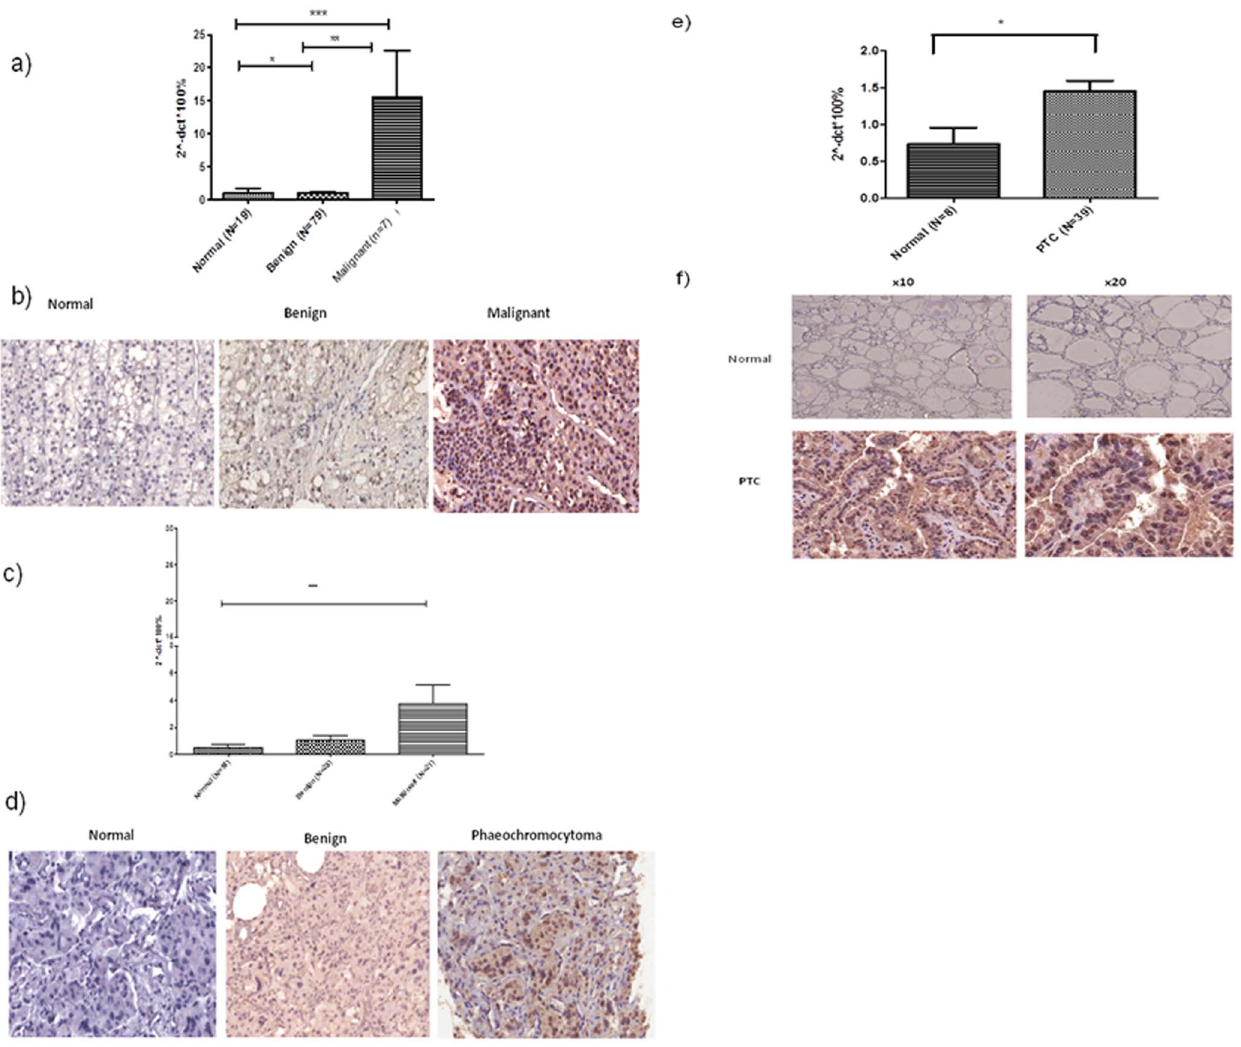
Figure 1. ZNF367 mRNA and protein levels in adrenocortical carcinoma, papillary thyroid cancer, and pheochromocytoma/ paraganglioma compared to benign and normal tissue samples for each cancer type. (A and B) Expression level in the normal adrenal cortex, benign adrenocortical adenomas, and adrenocortical carcinomas; (C and D) normal adrenal medulla, benign and malignant pheochromocytoma/paraganglioma tissue samples; and (E and F) normal thyroid and papillary thyroid cancer tissue samples. The Y axis on each graph represents the percentage of mRNA expression using the 2 ‘ - D Ct *100% method 6 SEM. *p , 0.05, **p , 0.001, ***p , 0.001 (Kruskal-Wallis test). Representative immunohistochemistry images are from normal, benign, and malignant tumor samples at 20X